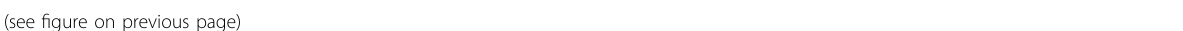
Fig. 3 ERK1/2 activation regulates autophagosome – lysosome fusion during early stage of resistance. A Representative images of A2780, A2780Dual ER , and A2780Dual LR cells expressing mCherry-EGFP-LC3 post 24 h of CisPac treatment alone or in combination with U0126. Yellow puncta [colocalization between mCherry (red) and EGFP (green)] indicate autophagosomes and red puncta (mCherry) denote autophagolysosome. A2780Dual ER cells showed increased red puncta post CisPac treatment, while CisPac + U0126 treatment reduced number of red puncta and increased yellow puncta. Compared to the number of red puncta, higher numbers of yellow puncta were observed in A2780 and A2780Dual LR cells. B , C Graphical representation of mCherry/EGFP ratio and Mander ’ s colocalization coef fi cient of mCherry and EGFP puncta. A2780Dual ER cells showed increased mcherry/EGFP ratio (4.11) and reduced yellow puncta (colocalization coef fi cient: 0.48 + 0.06) post CisPac treatment, while CisPac + U0126 treatment reduced mcherry/EGFP ratio (1.91) and increased yellow puncta (colocalization coef fi cient: 0.70 ± 0.04). A2780 and A2780Dual LR cells showed reduced mcherry/EGFP ratio (1.91 and 1.17, respectively) and increased yellow puncta (colocalization coef fi cient: 0.71 ± 0.04 and 0.61 ± 0.01, respectively; n = 35 cells/group). D Representative images of sensitive, early and late resistant cells of A2780 chemoresistant models, immunostained with LC3 (green, autophagosome) and LAMP1 (red, lysosome) post 24 h of CisPac treatment alone or in combination with U0126. Yellow puncta depict autophagosome – lysosome fusion. The white square insets represent the magni fi ed images. E Graphical representation of the number of LC3 + ve LAMP1 + ve puncta in sensitive, early and late resistant A2780 cells treated with CisPac alone or in combination U0126 for 24 h. CisPac treatment for 24 h induced maximal LC3 + ve LAMP1 + ve puncta in A2780Dual ER (27.16 ± 2.71) cells compared to sensitive (2.96 ± 0.84) and late resistant (7.87 ± 1.48) cells of A2780 model. Combinatorial treatment of U0126 along with CisPac reduced LC3 + ve LAMP1 + ve puncta by fi vefold (5.3 ± 0.59 puncta/cell) in A2780Dual ER cells ( n = 35 cells/group). F Number of LC3 + ve puncta in sensitive, early and late resistant A2780 cells treated with CisPac (138.14 ± 11.98, 107 ± 6.95, 58.92 ± 4.96, respectively) alone or in combination U0126 (125.6 ± 10.79, 137.6 ± 10.62, 58.92 ± 5.65, respectively). G , H Graphical representation of surface area and volume of LC3 puncta in sensitive, early and late resistant A2780 cells treated with CisPac alone or in combination U0126. Increased surface area and volume of these puncta was observed in A2780Dual ER cells post CisPac treatment (0.14 ± 0.003 and 0.06 ± 0.003µm 3 , respectively) compared to untreated cells (0.06 ± 0.004 and 0.015 ± 0.002µm 3 , respectively), which further enhanced upon application of U0126 and platinum – taxol (0.184 ± 0.007 and 0.083 ± 0.004 µm 3 , respectively). ( n = 30 – 40 cells/group, average area and volume was calculated from ~5000 puncta, data represent mean ± SEM of at least two independent experiments, ns indicates nonsigni fi cant, * p < 0.05, ** p < 0.005, *** p < 0.0005 as calculated by unpaired t test). I Immunoblot depicting increased UVRAG level in A2780Dual ER and OAW42Dual ER cells treated with platinum – taxol compared to cells treated with U0126 and platinum – taxol. J Immunoblot depicting reduction in Rab7 level in A2780Dual ER and OAW42Dual ER cells treated with U0126 and platinum – taxol. K CisPac treatment reduced UVRAG and Rab7 in A2780Dual ER/ERK1 (shERK1) compared to parental